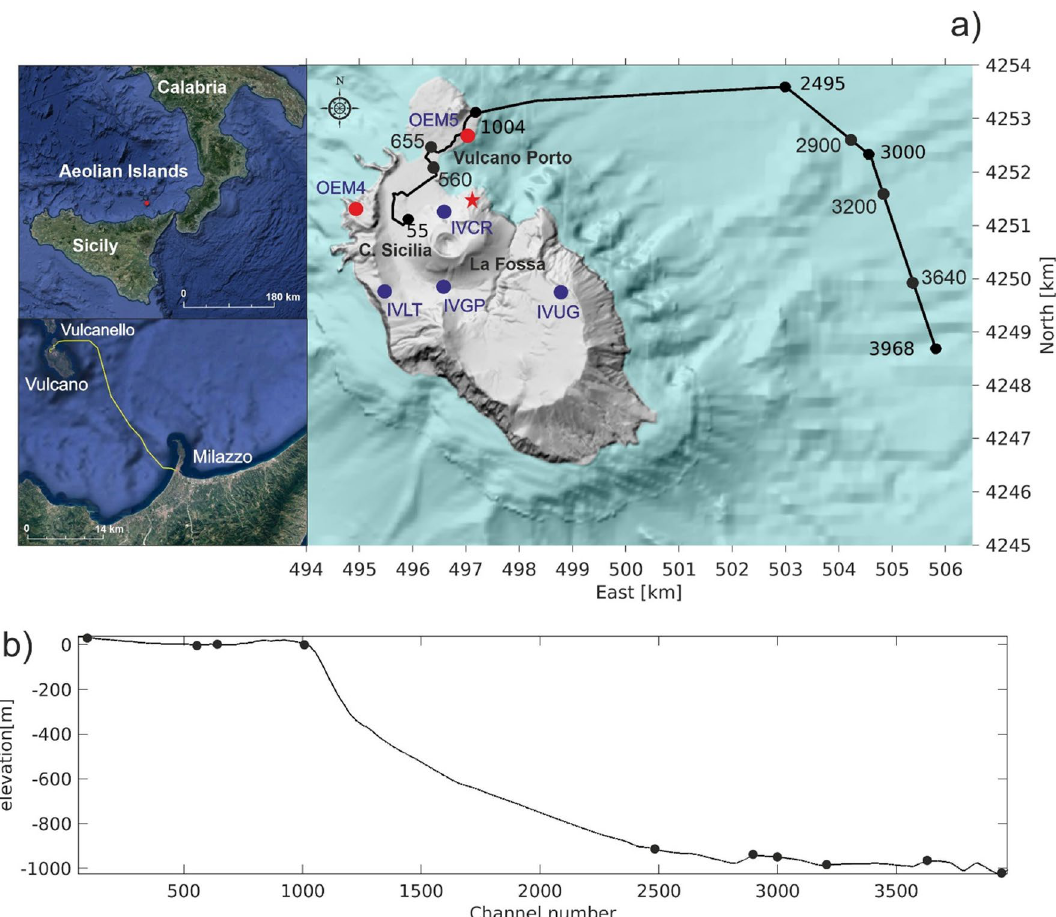
Figure 1. ( a ) Location map of TIM fiber optic cable connecting Vulcano to Milazzo interrogated by a DAS device hosted at the TIM power station of Vulcano. Permanent (IV*, blue dots) and mobile (OEM*, red dots) broadband seismic stations operating at Vulcano and used in the analysis are also reported. ( b ) Topographic and bathymetric profile along the fiber-optic cable route. Fiber channel numbers at specific locations are shown (black dots). The red star indicates the location of the source of the VLP events, obtained by a grid search method based on radial semblance function 30,51